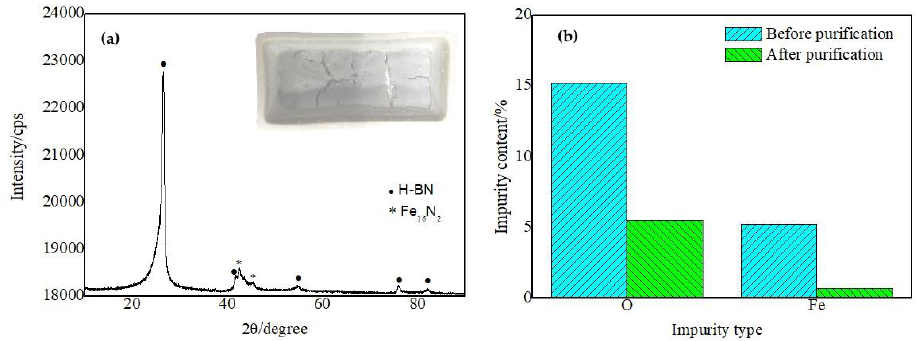
Figure 9. XRD pattern and optical image (inset) of the product after purification ( a ). Impurity content of products before and after purification ( b ).